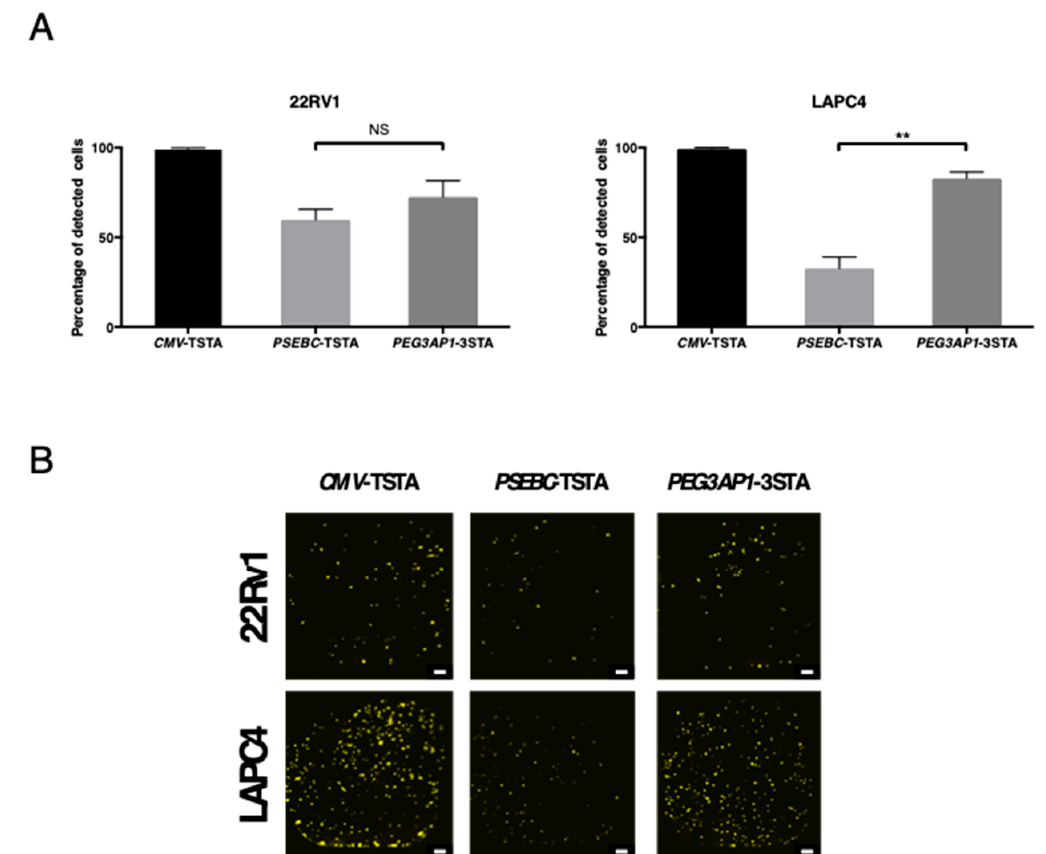
Figure 4. The PEG3AP1 -3STA system targeted heterogeneous PCa cell populations in AR+ cell lines more efficiently than did PSEBC -TSTA. 22Rv1 and LAPC4 GFP-expressing cells were transduced with CMV -TSTA, PSEBC -TSTA, or PEG3AP1 -3STA adenovirus. ( A ) Percentage of detected cells (number of luciferase-positive cells ÷ number of GFP-expressing cells) × 100. Significant differences are indicated by asterisks (** p < 0.01). “NS” indicates no significant difference between samples. ( B ) Representative images of bioluminescence microscopy. Seventy-two hours after transfection, bioluminescence microscopy imaging was performed. Scale bar represents 200 μ m.